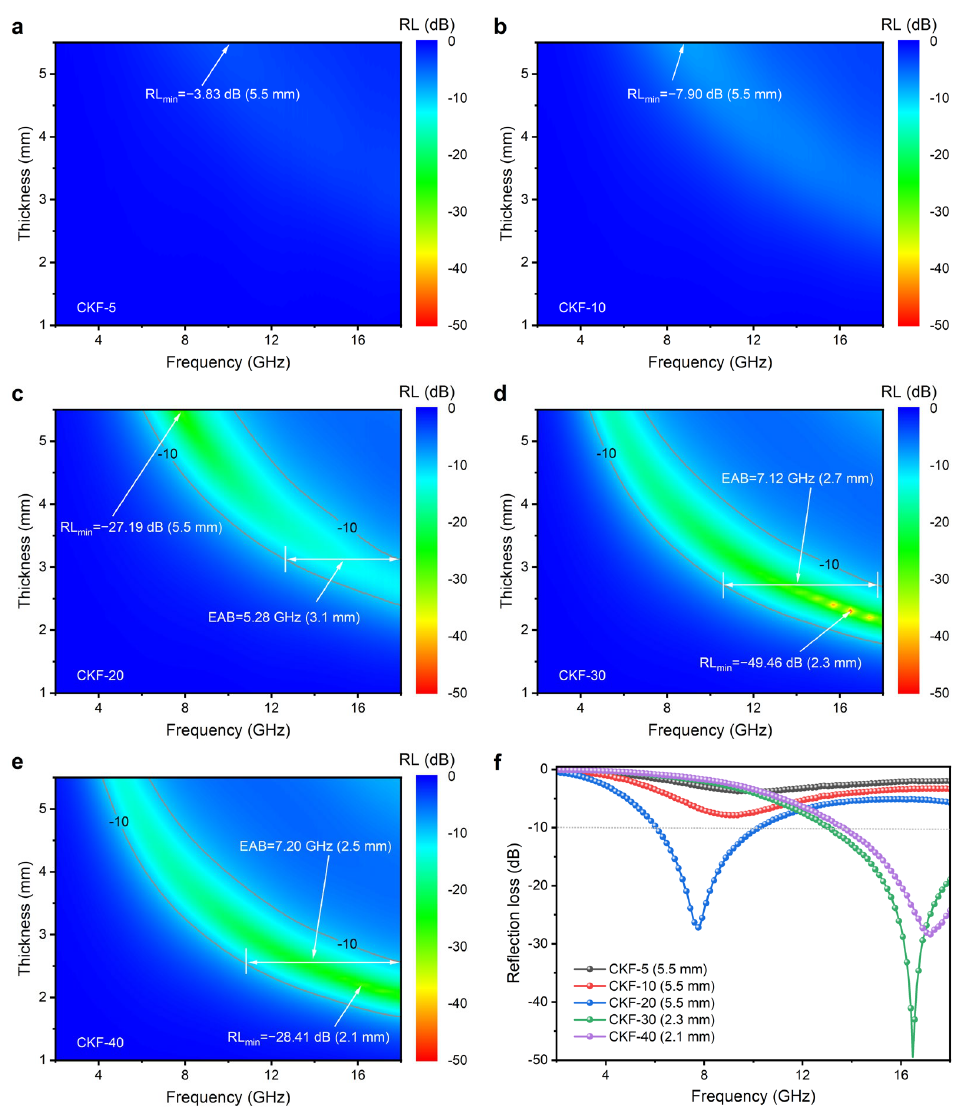
Figure 5. ( a – e ) Dependence of filler loading on the reflection loss and ( f ) extracted reflection loss curves at the optimized thickness of CKF-filled paraffin composites.